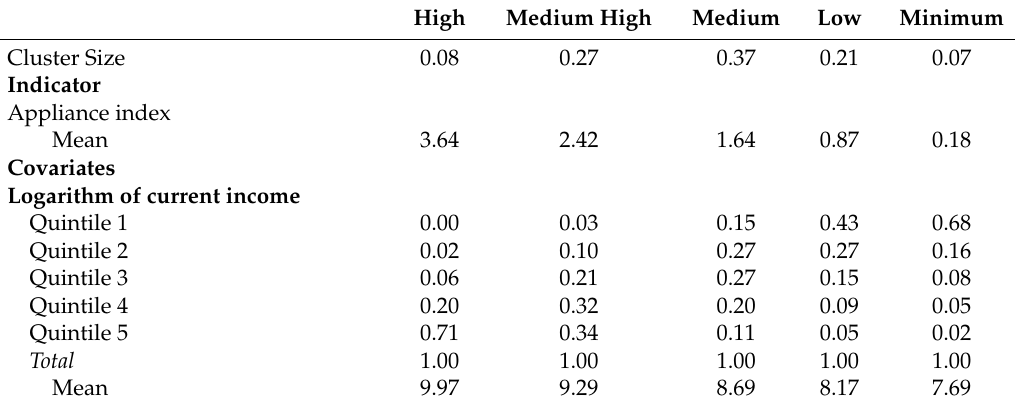
Table A5. Profiles of consumer practices latent classes. Mexico